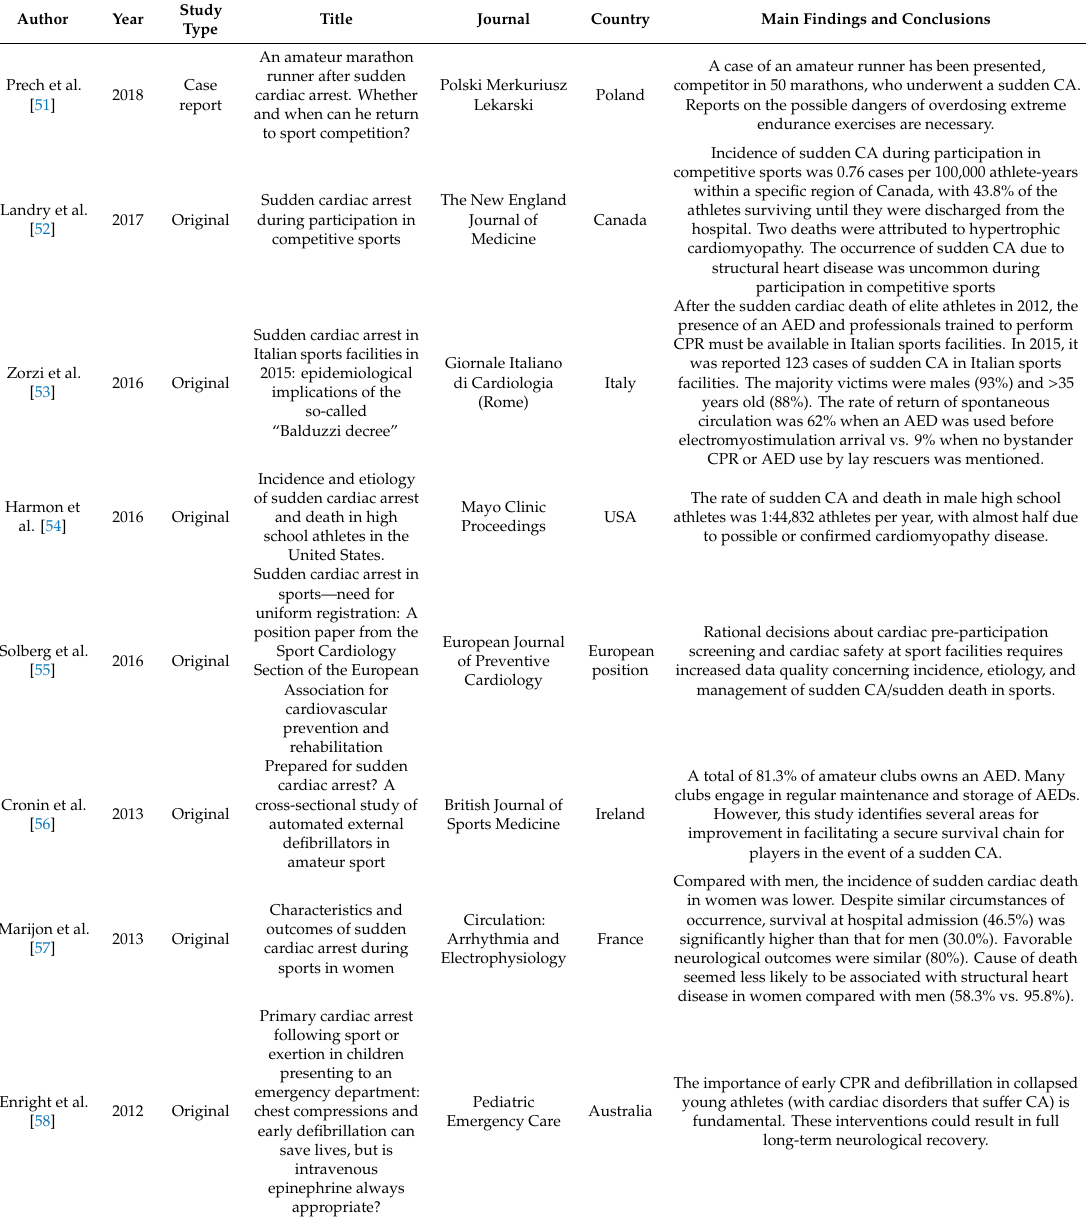
Table 4. Studies and their main conclusions related to cardiac arrest (CA) in the sport